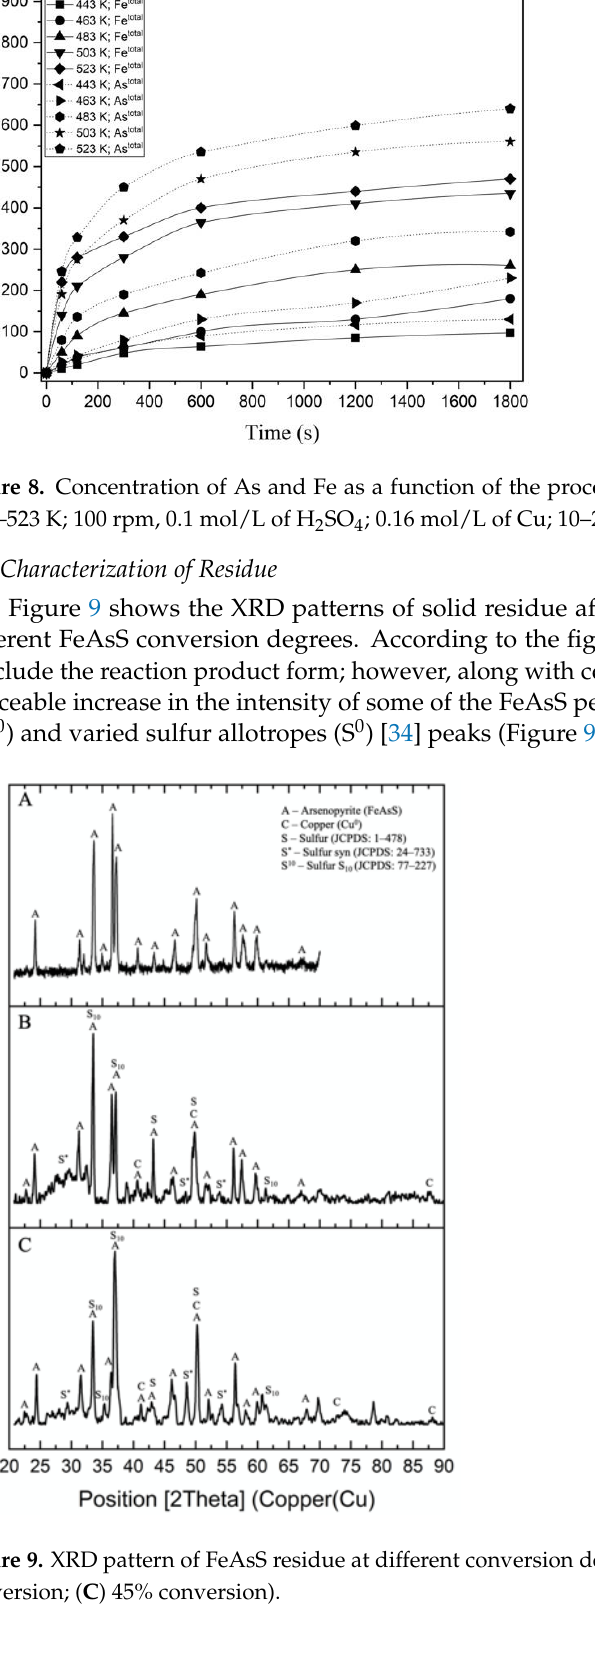
Table 2. Normalized chemical composition of the FeAsS residue before ( 1 ) and after ( 2 ) treatment in sodium sulfide solution (wt. %).